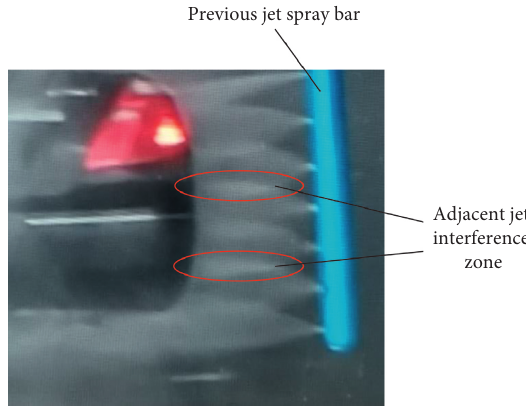
Figure 20: Nozzle jet before